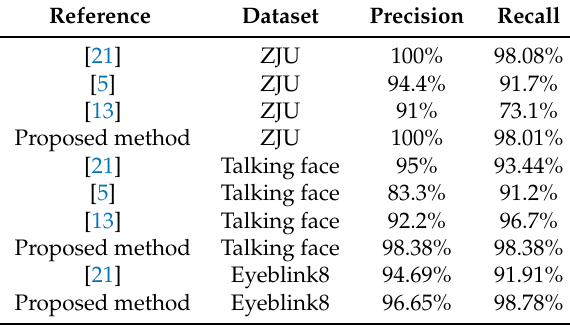
Table 2. Results of the proposed technique and of other existing